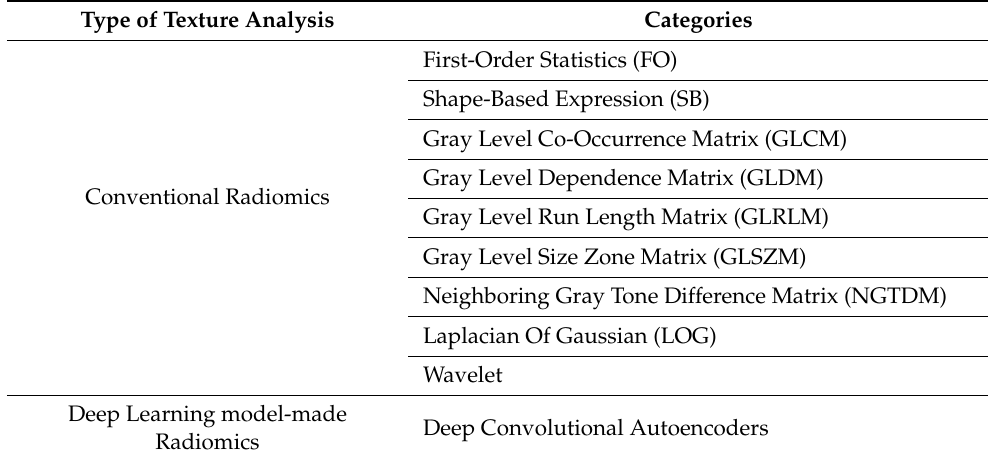
Table 1. The proposed application of conventional and modified deep learning texture